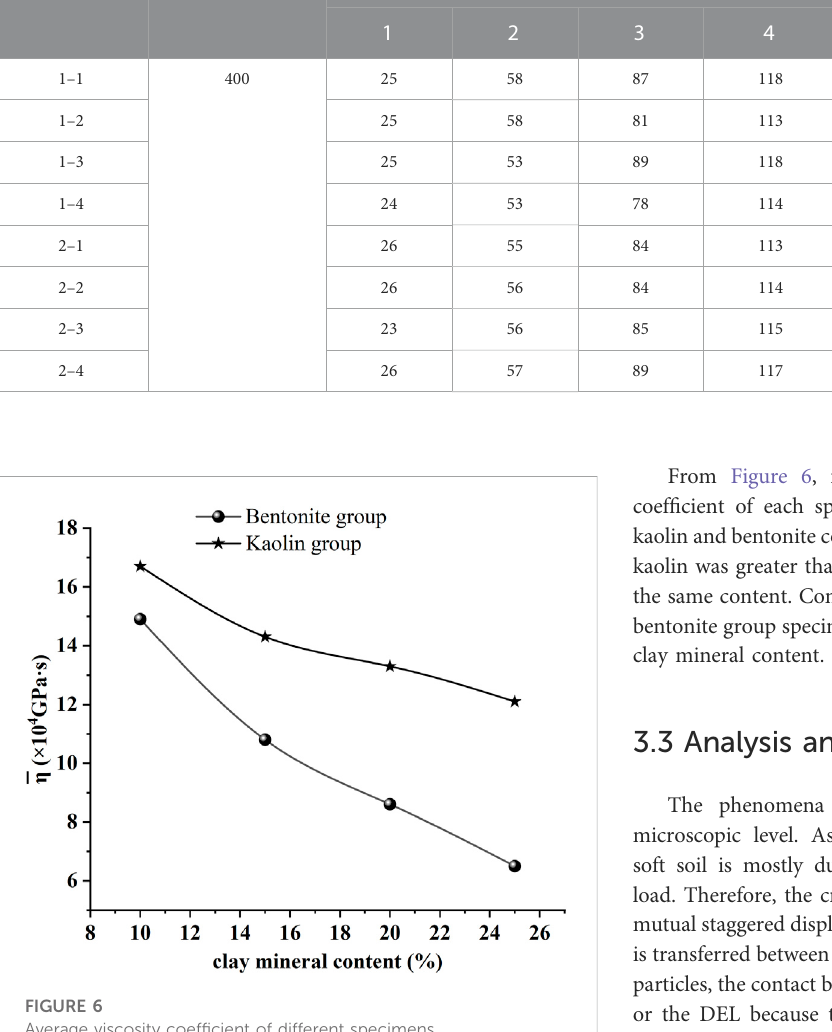
TABLE 4 Direct shear test scheme for different groups of specimens.